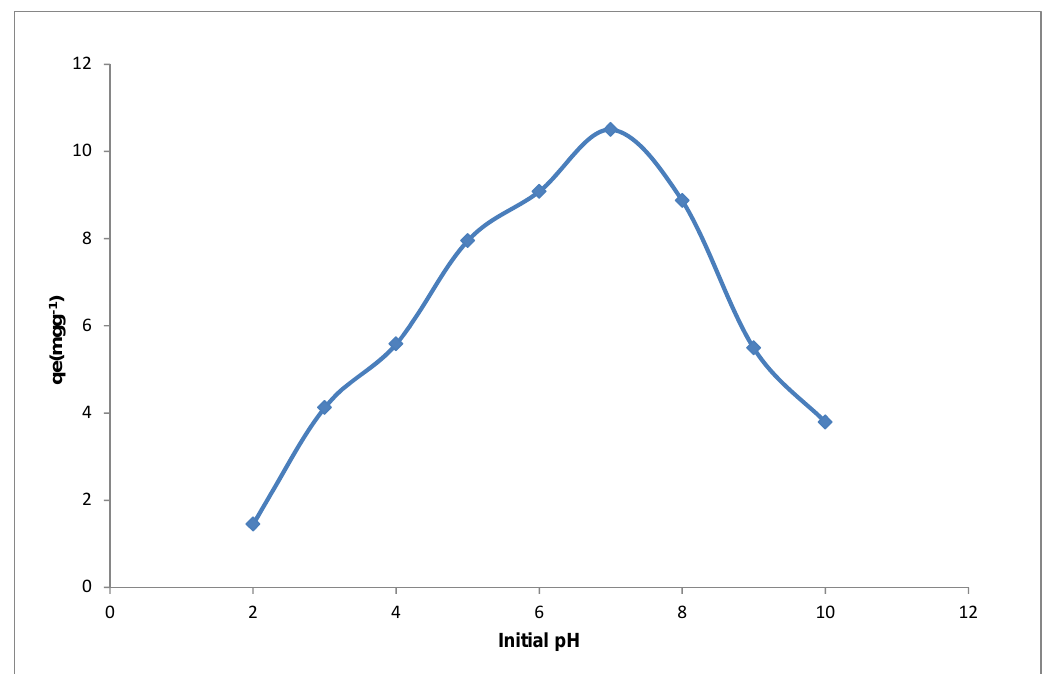
Figure 9. Effect of pH on Cd(II) ion sorption onto YTBS adsorbent.